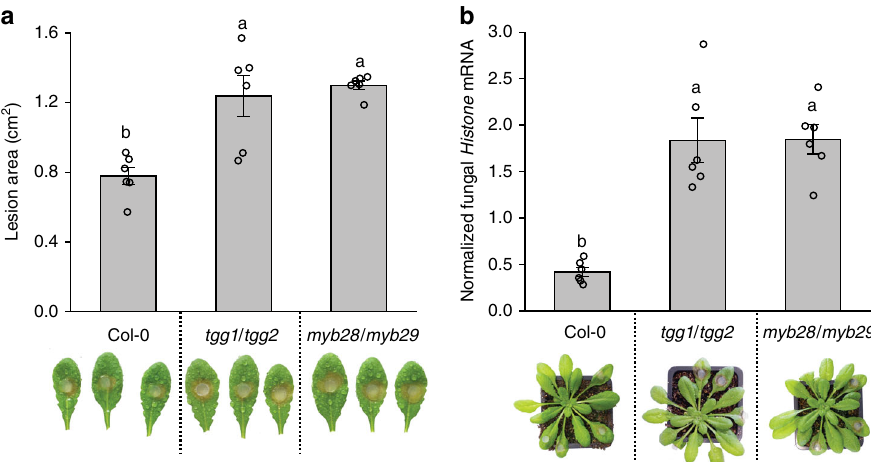
Fig. 1 A. thaliana aliphatic ITC- and GL-de fi cient mutants are hyper-susceptible to S. sclerotiorum . a Comparison of lesion areas caused by S. sclerotiorum 24 h post inoculation (hpi) on leaves of A. thaliana Col-0 wild-type , tgg1/tgg2 and myb28/myb29 mutants. The tgg1/tgg2 line is a myrosinase-defective mutant, and the myb28/myb29 line is de fi cient in aliphatic GL biosynthesis. b Relative quanti fi cation of S. sclerotiorum growth on A. thaliana lines for 24 h as quanti fi ed by qRT-PCR. The S. sclerotiorum Histone mRNA was normalized by the A. thaliana ACTIN2 mRNA to quantify relative fungal colonization. Data represent mean ± SEM ( n = 6 inoculated leaves and plants, respectively; inoculation with detached leaves was repeated once) and were analyzed by one- way ANOVA ( p < 0.001) followed by Tukey ’ s post-hoc test. Different letters above the bars indicate signi fi cant differences at p < 0.05. Source data are provided as a Source data fi